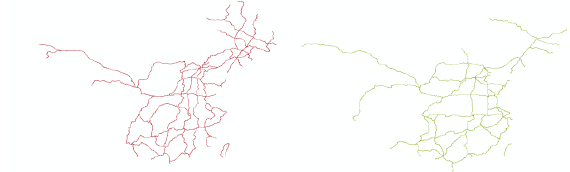
Figure 2. Railroad and road data in